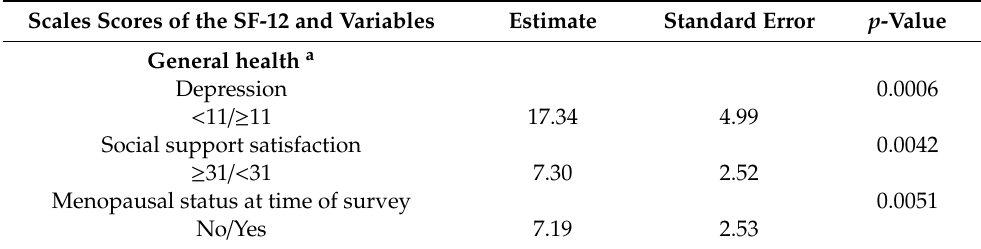
Table 3. Significant determinants of health-related quality of